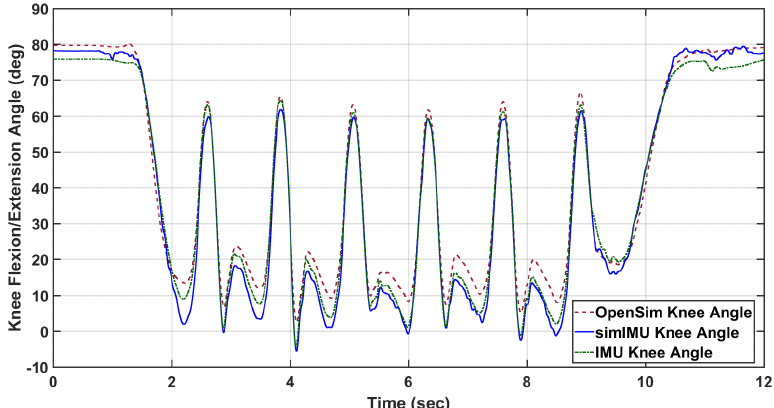
Figure 2. Example absolute knee angle data, shown for subject Y2, TUGT trial 6. Shown are the measured IMU data (IMU, absolute RMSE = 5.35 ◦ , zero-mean RMSE = 4.58 ◦ ) and simulated IMU data from the marker triads (simIMU, absolute RMSE = 5.84 ◦ , zero-mean RMSE = 2.94 ◦ ) against the OpenSim knee angle